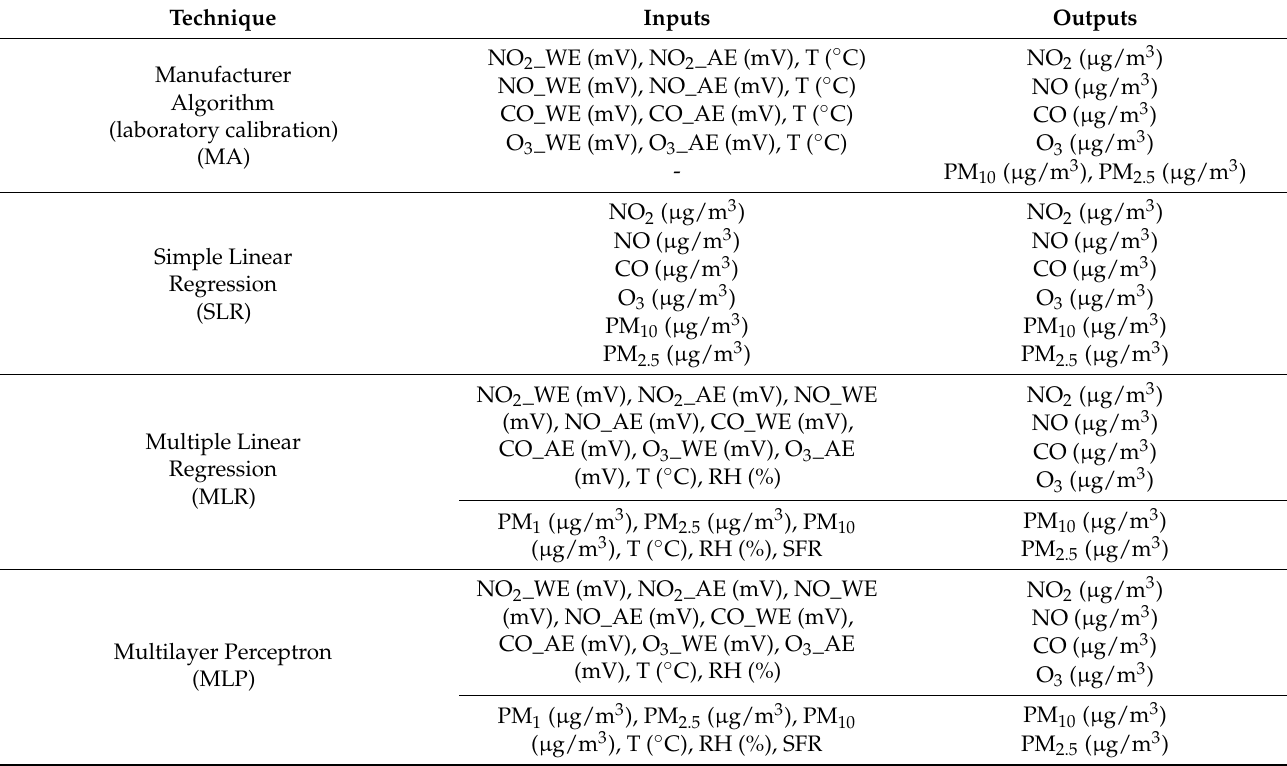
Table 1. Summary of calibration algorithms applied to the air quality data from low-cost sensors.